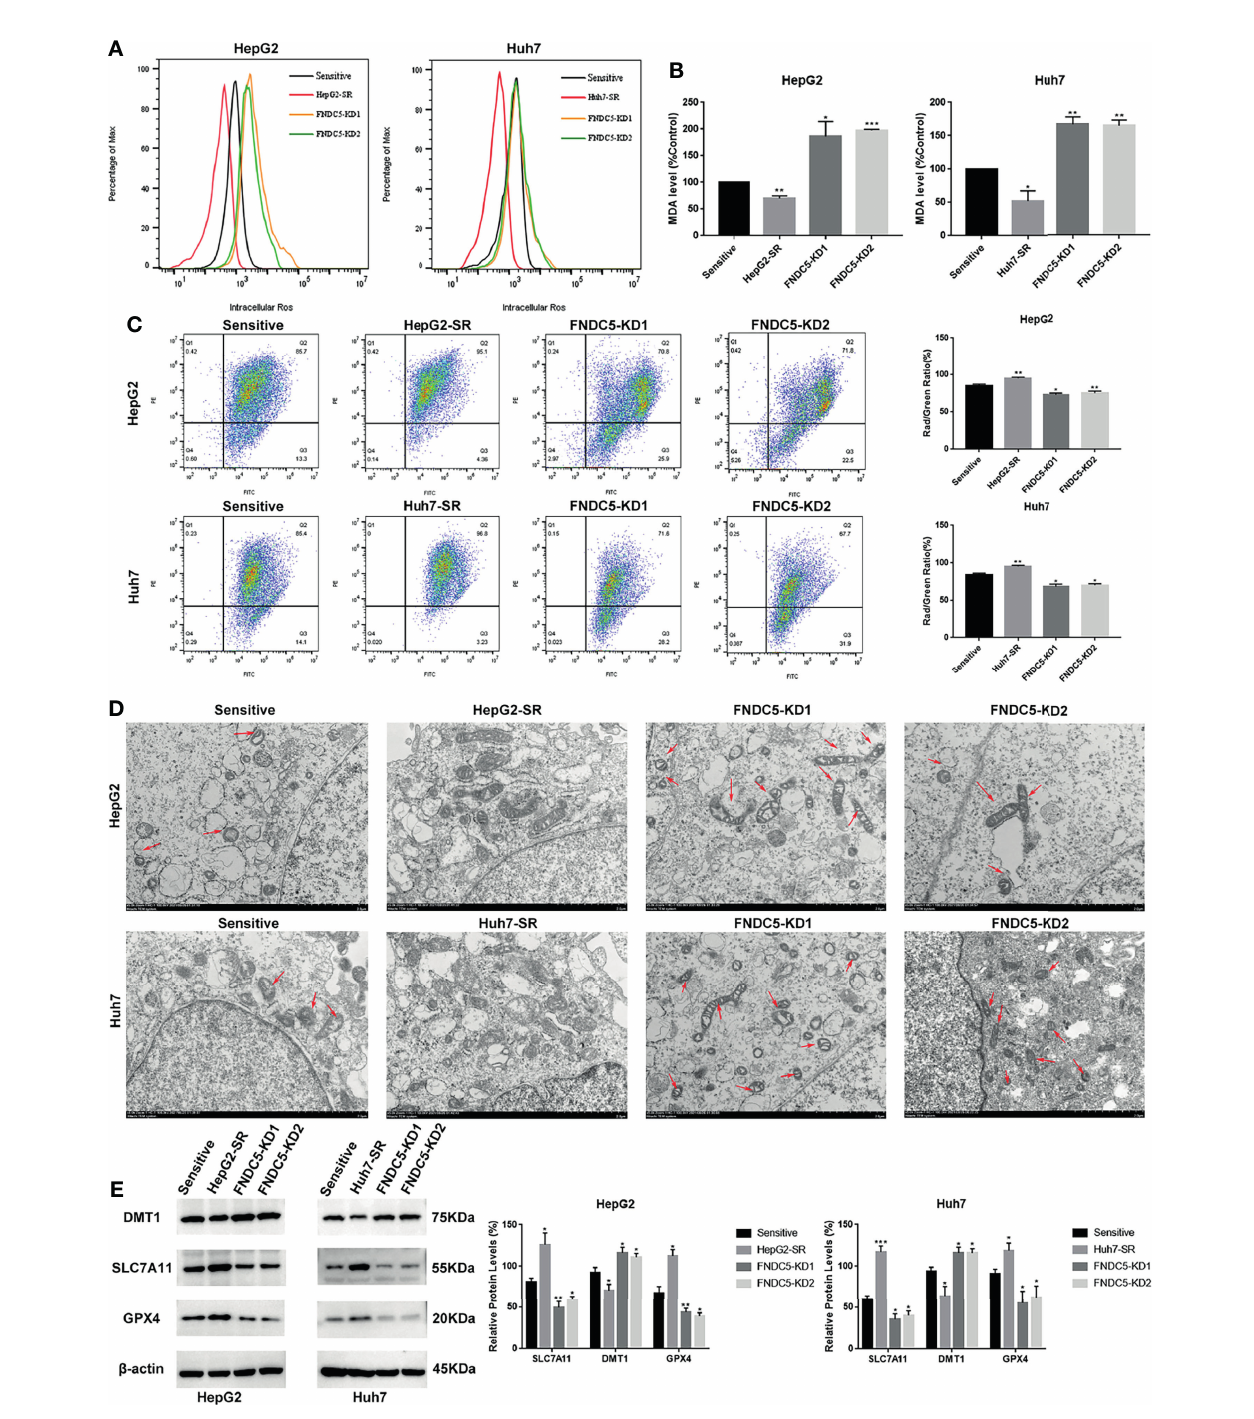
FIGURE 3 | Effect of alterations in the expression level of FNDC5 on sorafenib-induced levels of ferroptosis in HCC cells. (A, B) . After 24 h of treatment of sorafenib- sensitive HCC cells, drug-resistant, and FNDC5-knockdown drug-resistant cells with sorafenib (10 µM), the levels of ROS and MDA were measured to assess the level of ferroptosis in each group of cells. (C) . Flow cytometry was used to detect changes in mitochondrial membrane potential in each group of cells. (D) The mitochondrial morphology in each group of cells was observed under an electron microscope, with red arrows indicating mitochondria with altered membrane potential. (E) Western blotting for detecting the level of ferroptosis markers in each group of cells. *Compared with the sorafenib-sensitive HCC cells, *p < 0.05, **p < 0.01, ***p <